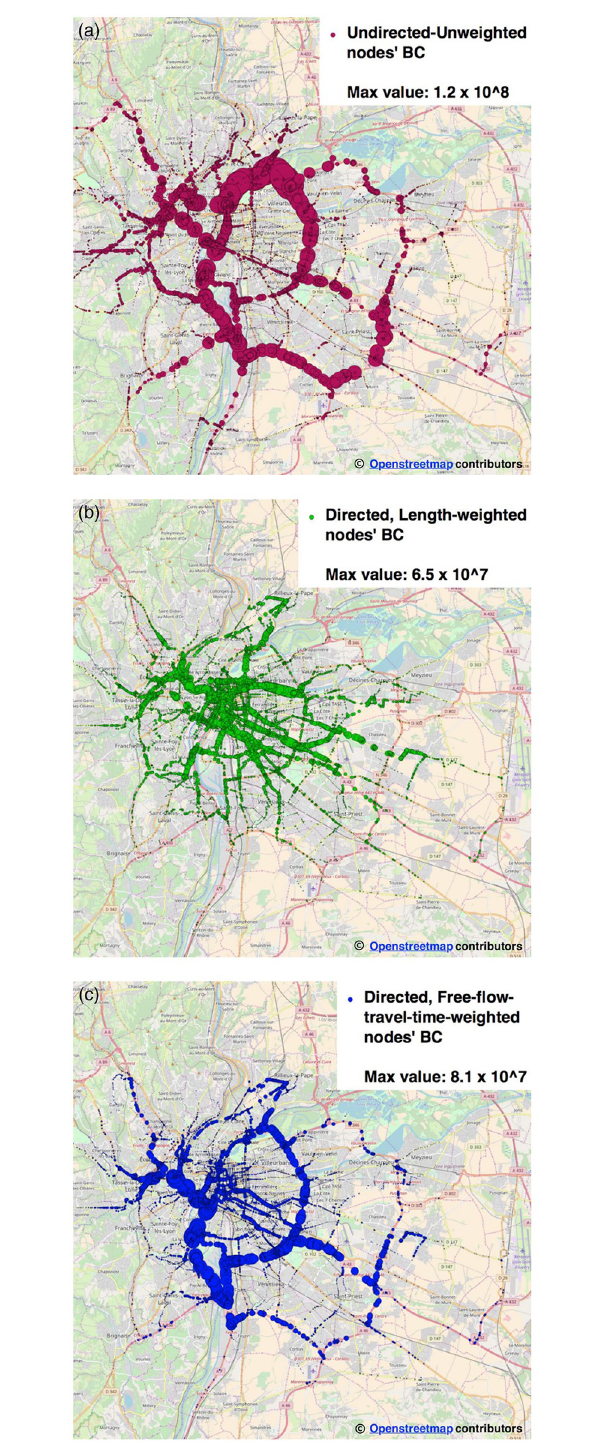
Fig 3. Three static topological instances of the Rhone-OBS graph: Comparison of BC values. (a) Undirected, unweighted (circle size proportional to node’s BC) (b) Directed, length-weighted (circle size proportional to node’s BC) (c) Directed, free-flow-travel-time-weighted (circle size proportional to node’s BC).